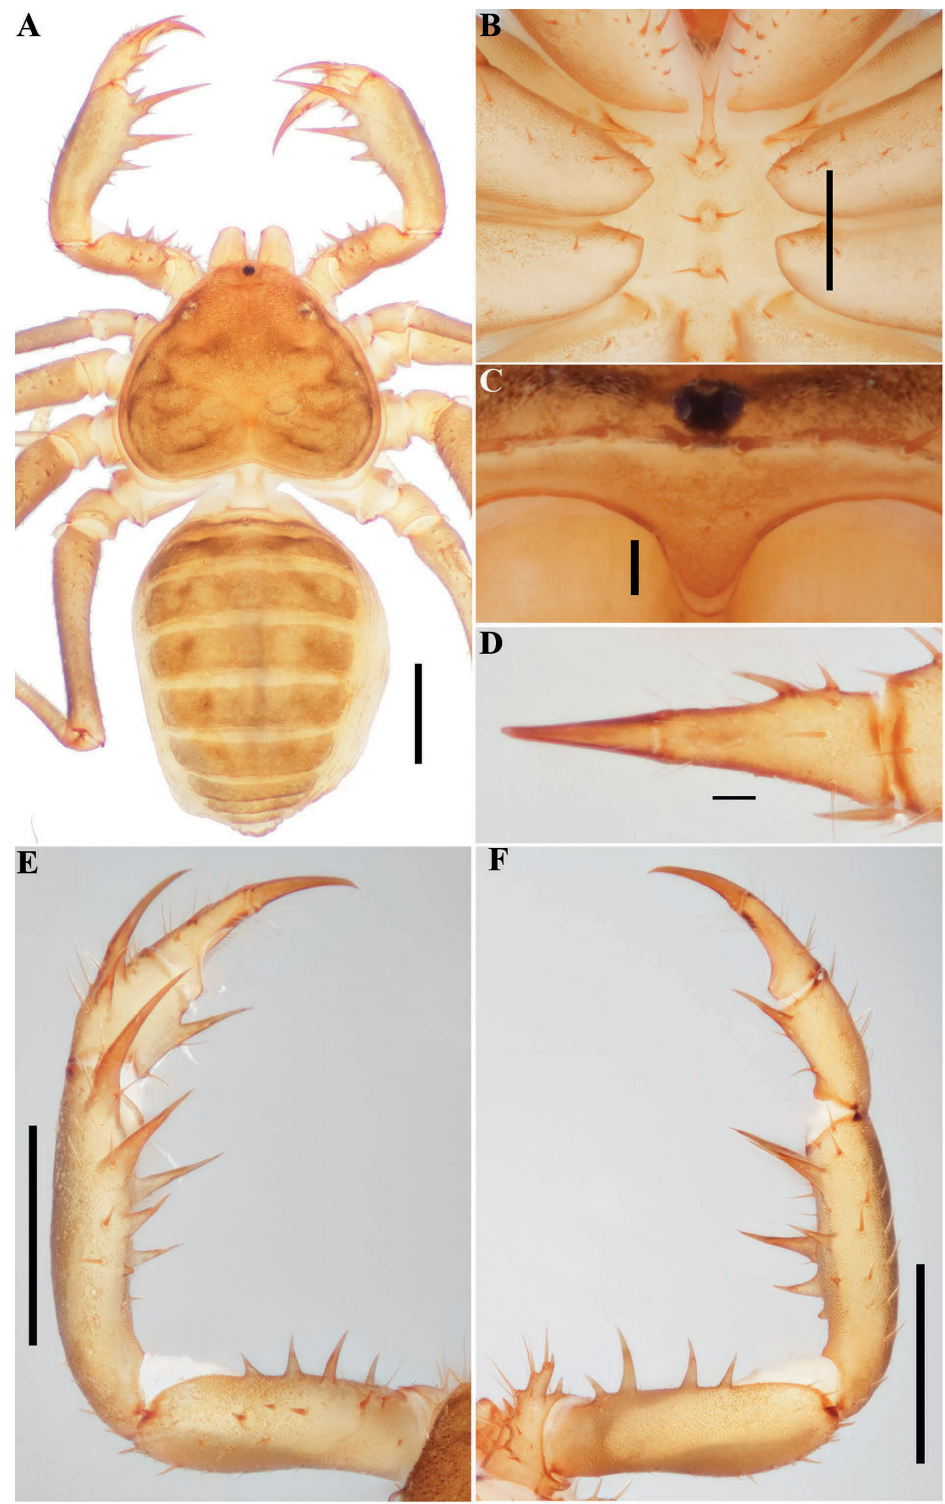
Fig. 33. Charinus sillami Réveillion & Maquart, 2015 (AMCC [LP 13448]), general morphology, ♀. A . Habitus, dorsal view. B . Sternum, ventral view. C . Frontal process. D . Pedipalp tarsus, frontal view. E . Pedipalp, dorsal view. F . Pedipalp, ventral view. Scale bars: A, E–F = 1 mm; B = 0.5 mm; C–D = 0.1